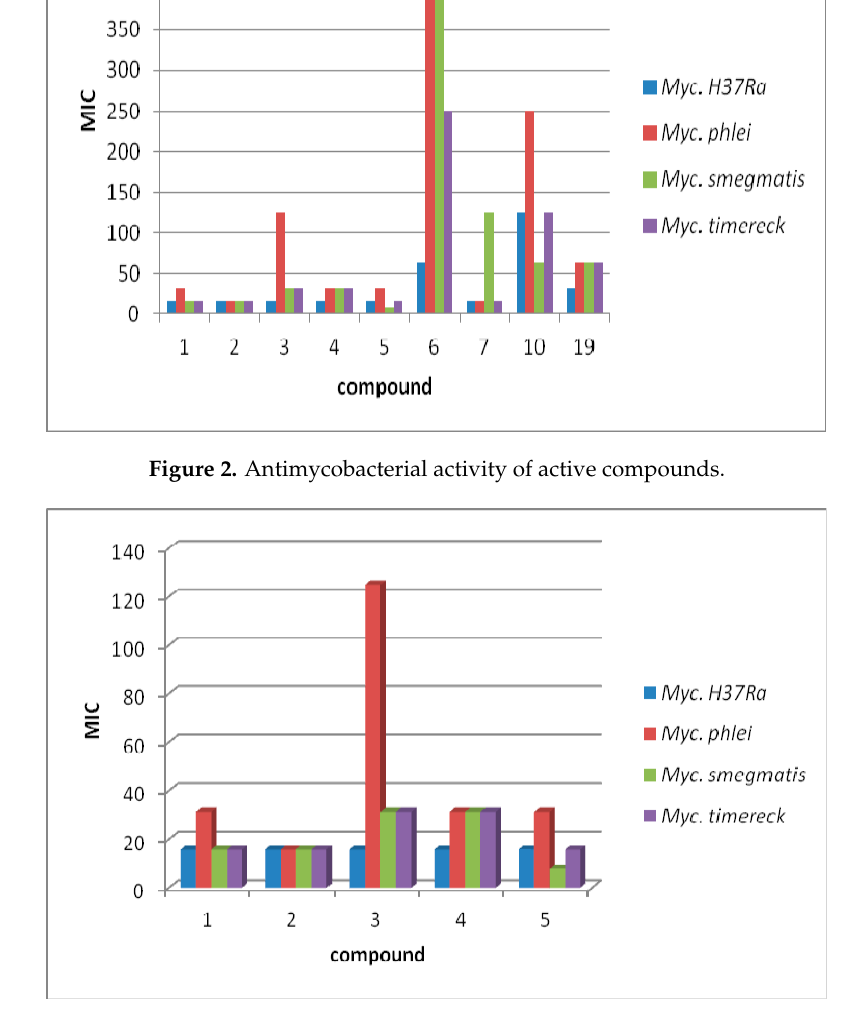
Figure 3. Antimycobacterial activity of the most active compounds. Table 4. Minimal inhibitory concentration for tested